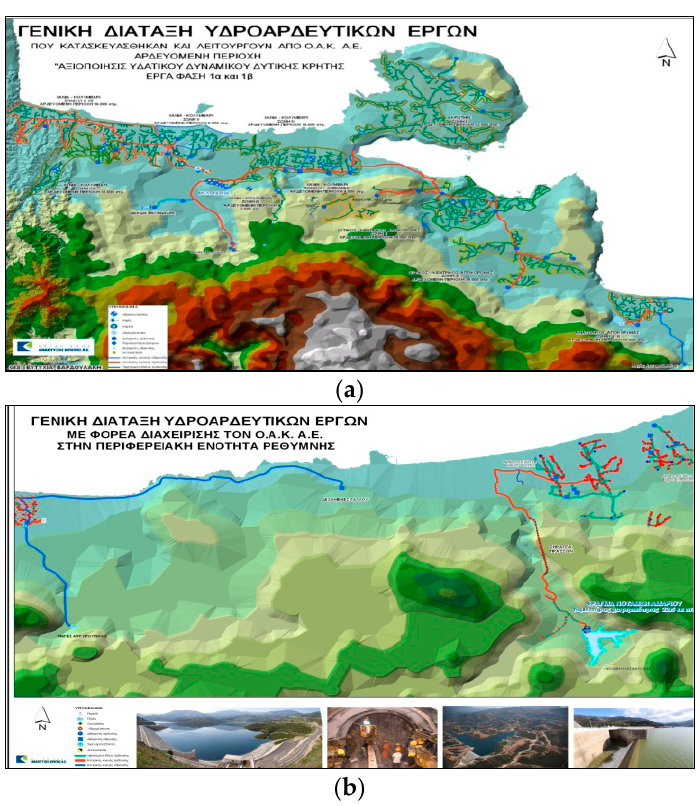
Figure 7. New dams: ( a ) Potamon (built in 2008); and ( b ) Valsamoti (built in 2014).